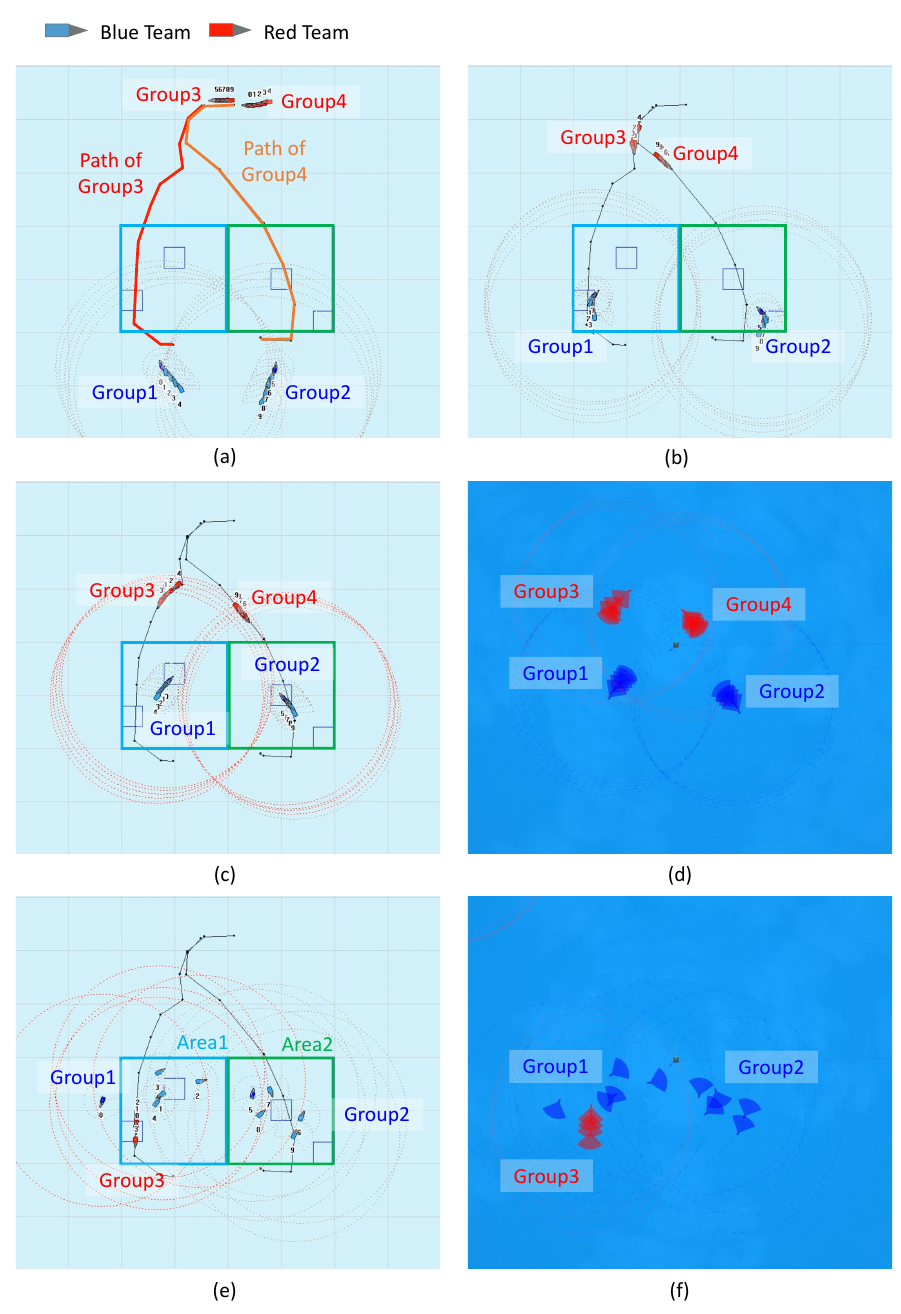
Figure 12. Simulation results of the proposed neuro-symbolic framework: ( a ) initial state, ( b ) blue team performing surveillance in a wide area based on symbolic approach, ( c ) blue team executing surveillance task output from the COP system, ( d ) blue team executing surveillance task in the Gazebo environment, ( e ) group 1 responding with a symbolic approach output from the COP system and group 2 responding to the red team with connectionist approach, ( f ) group 1 responding with symbolic approach in Gazebo environment and group 2 responding to the red team with a connectionist